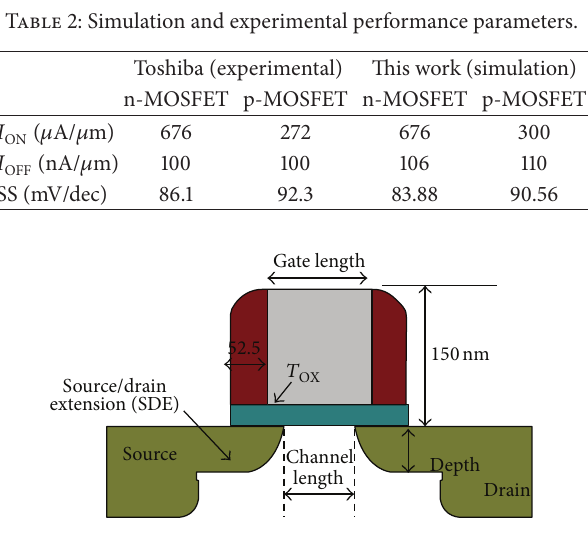
Figure 1: Cross-section drawing of a CMOS transistor.